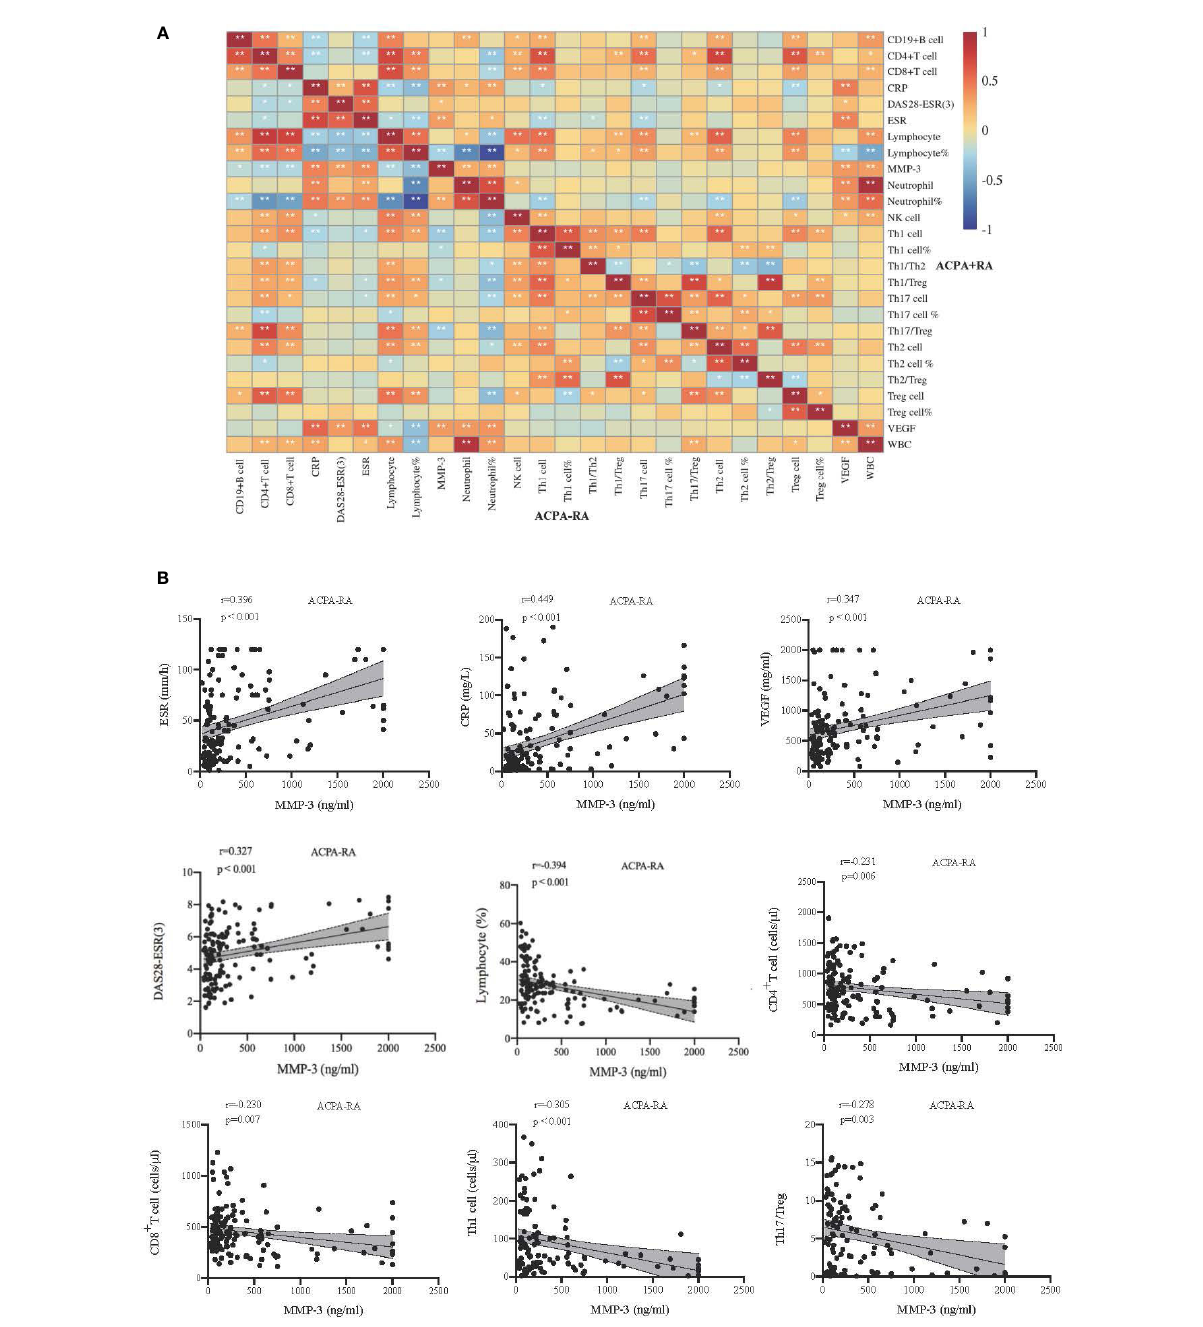
FIGURE 6 Correlations between indicators in RA subgroup. (A) The upper right corner and lower left corner of the heat map show the correlation of in fl ammatory markers and lymphocyte subsets in patients with ACPA + , ACPA - , respectively. (B) Correlation analysis between MMP-3 and some indexes in ACPA - patients. *p < 0.05, **p <